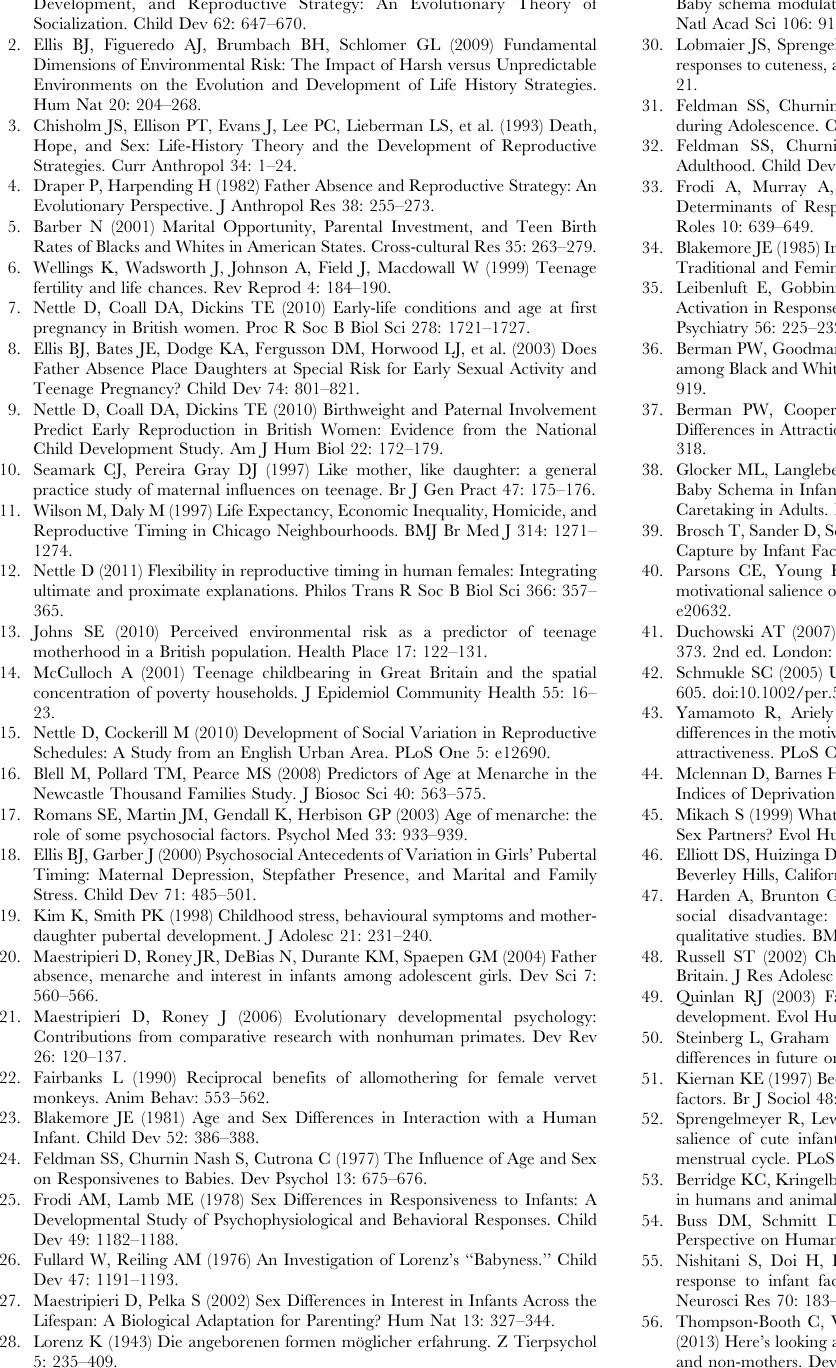
description of all variables analysed in this